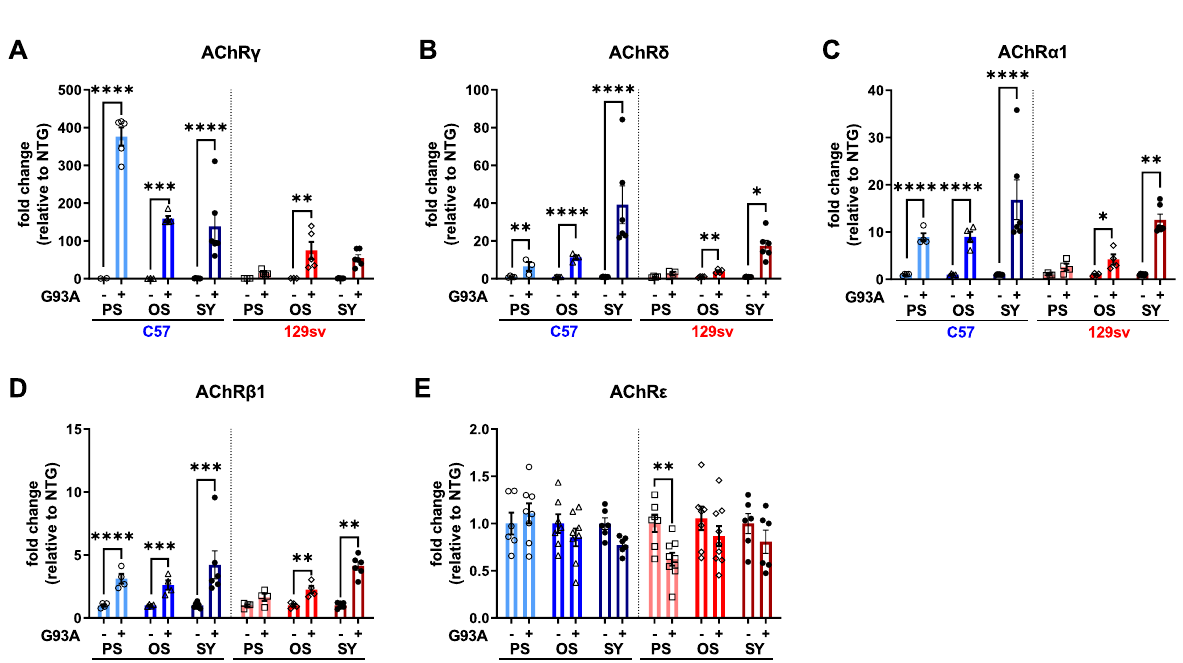
Fig. 2 Expression of the nicotinic acetylcholine receptor in skeletal muscles of fast and slow progressing mice. A – E Real-time qPCR analysis of AchRγ ( A ), AchRδ ( B ), AchRα1 ( C ), AchRβ ( D ), AchRε ( E ) mRNA transcripts in the GCM of C57SOD1 G93A and 129SvSOD1 G93A mice compared with NTG littermates ( n 2–9). Data are reported as mean SEM. Significance was calculated with 2-way ANOVA with uncorrected Fisher’s LSD post-analysis = ± (*